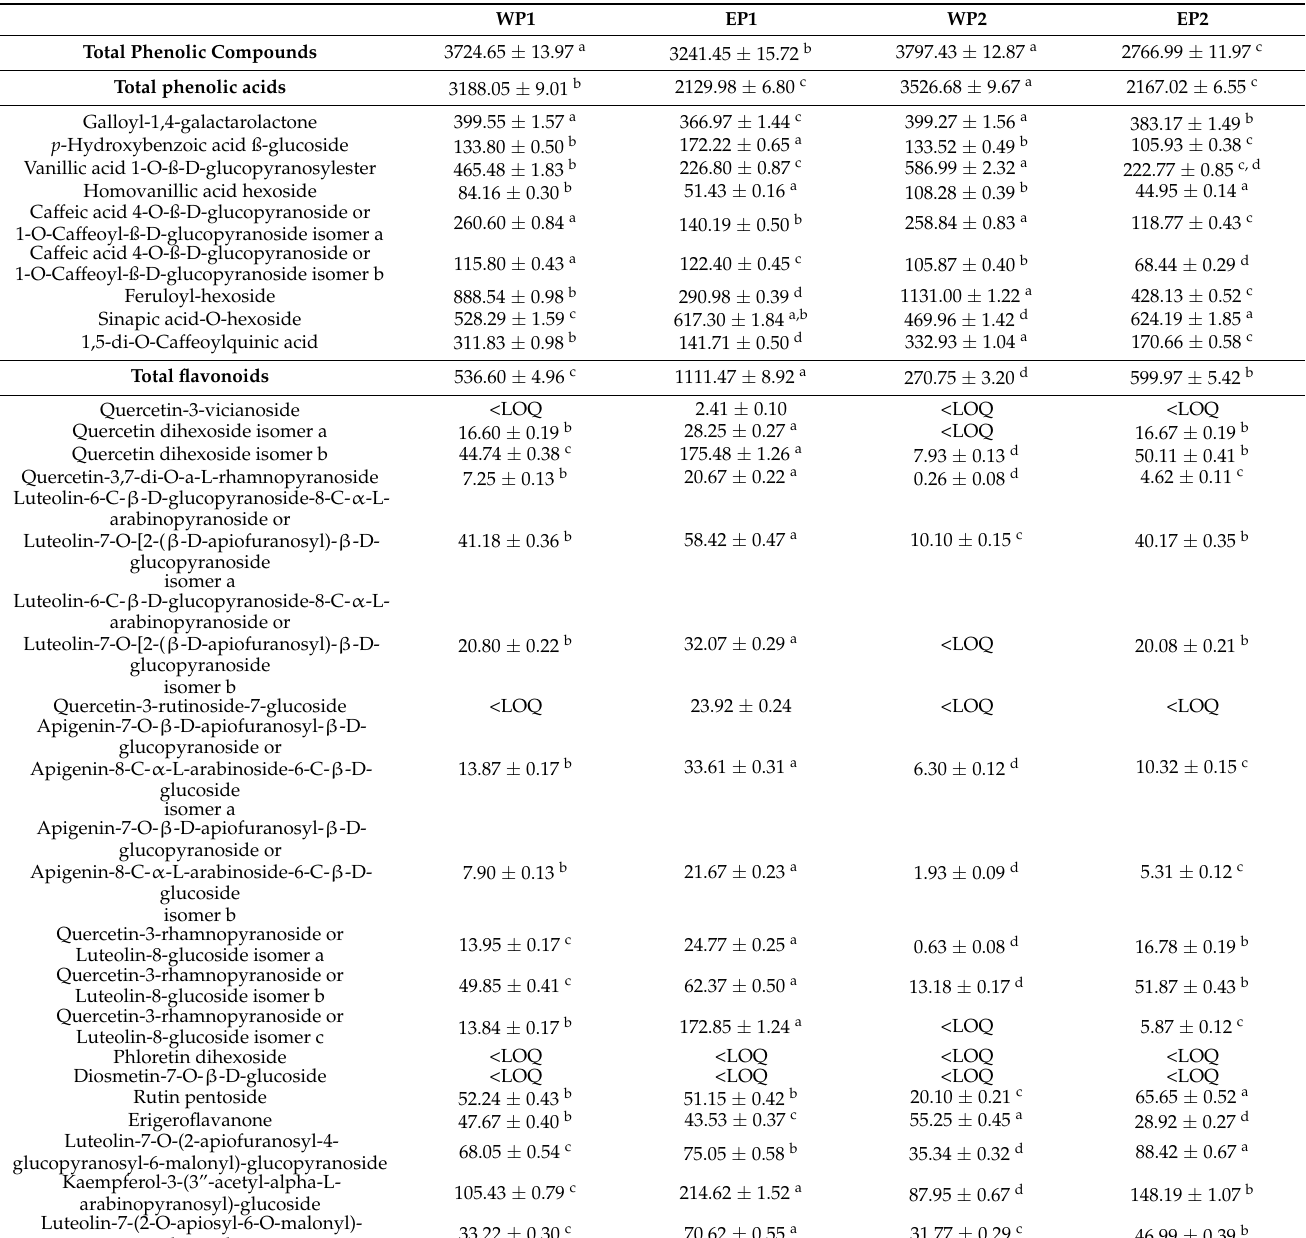
Table 7. Quantification of phenolic compounds in pepper samples by HPLC-MS (results are expressed as µ g/g